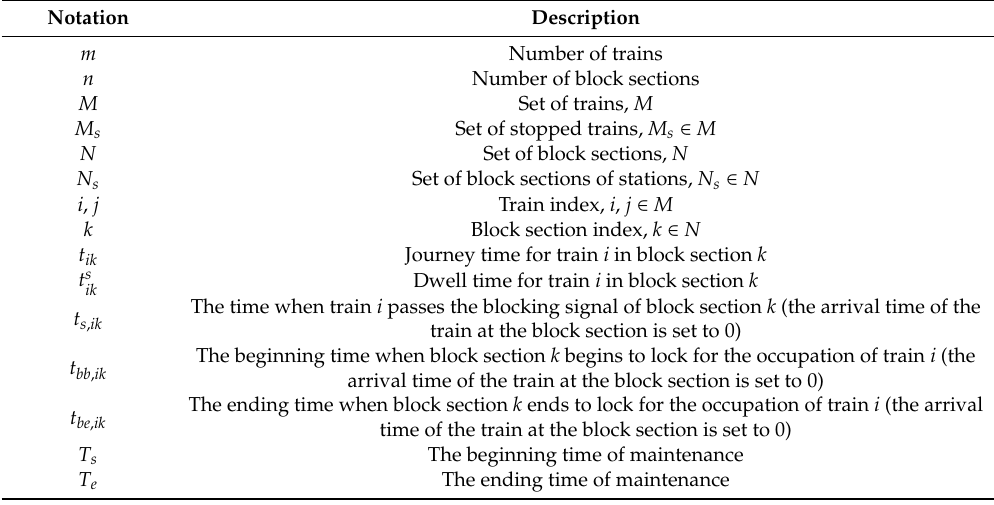
Table 3. Definition of the sets, indices and the parameters.